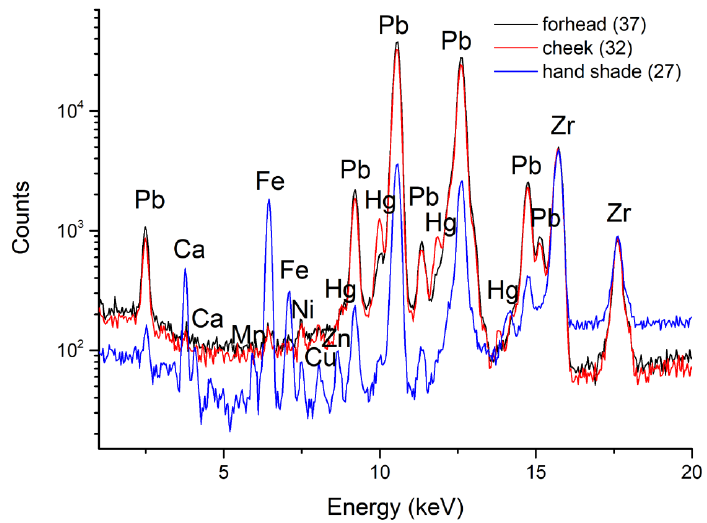
Figure 6. Comparison of XRF spectra of different flesh tones: light forehead (black line) with predominant presence of lead white (Pb), reddish cheek (red line) with higher amount of vermilion (Hg), and dark hand shade (blue line) with umber (Mn, Fe) and bone black (Ca). The principal yellow pigment used was yellow ochre (Fe) that was applied for the Virgin’s aureole, for her crown, and her hair. In low amounts it was added to other colors such as the sky, the landscape, or the sea below. However, for the highlights, Pacheco choose lead–tin yellow (Pb, Sn), which was identified on the crown (Figure 7), some trees, and a yellowish cloud. The principal red pigment was vermilion (Hg), used in flesh tones as well as, in high concentration, for the Virgin’s lips and the red flower on her crown. Pink flowers were made with lead white and very little of vermilion; probably, a red lake was also used. Since the latter one is an organic colorant, it cannot be detected by XRF, but high Ca peaks in this area suggest a possible calcium substrate for the liquid lake. A small amount of vermilion was added to the brownish color of the architecture underneath and even for the shades of the blue coat and the tunic. Red earth (Fe) was probably used as addition to other pigments, as well.